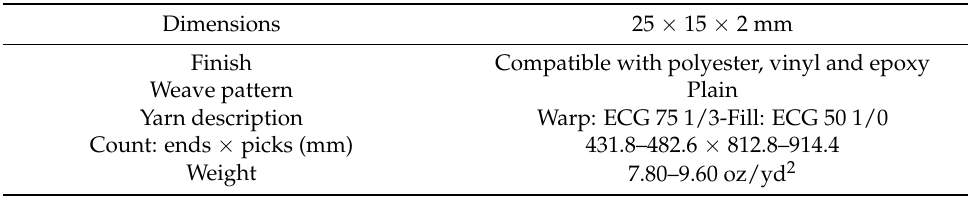
Table 3. Specific fiberglass